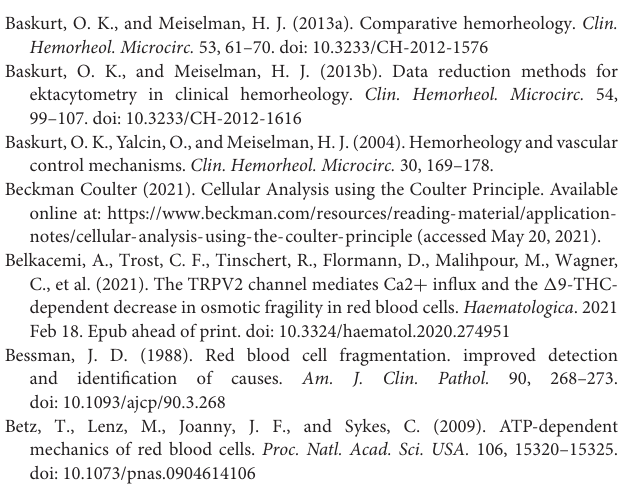
Supplementary Figure 1 | The histograms show a volume distribution of healthy control (purple curves), metabolically depleted (green curves), and oxidatively damaged (pink curves) RBCs before preconditioning with SS (A) and after preconditioning with 5 Pa (B) , 30 Pa (C) , 40 Pa (D) , 50 Pa (E) , 70 Pa (F) , and 100 Pa (G) SS. Supplementary Table 1 | Distribution width of RBC volume at different SS levels. Supplementary Table 2 | Significant differences between different volume ranges in healthy and damaged